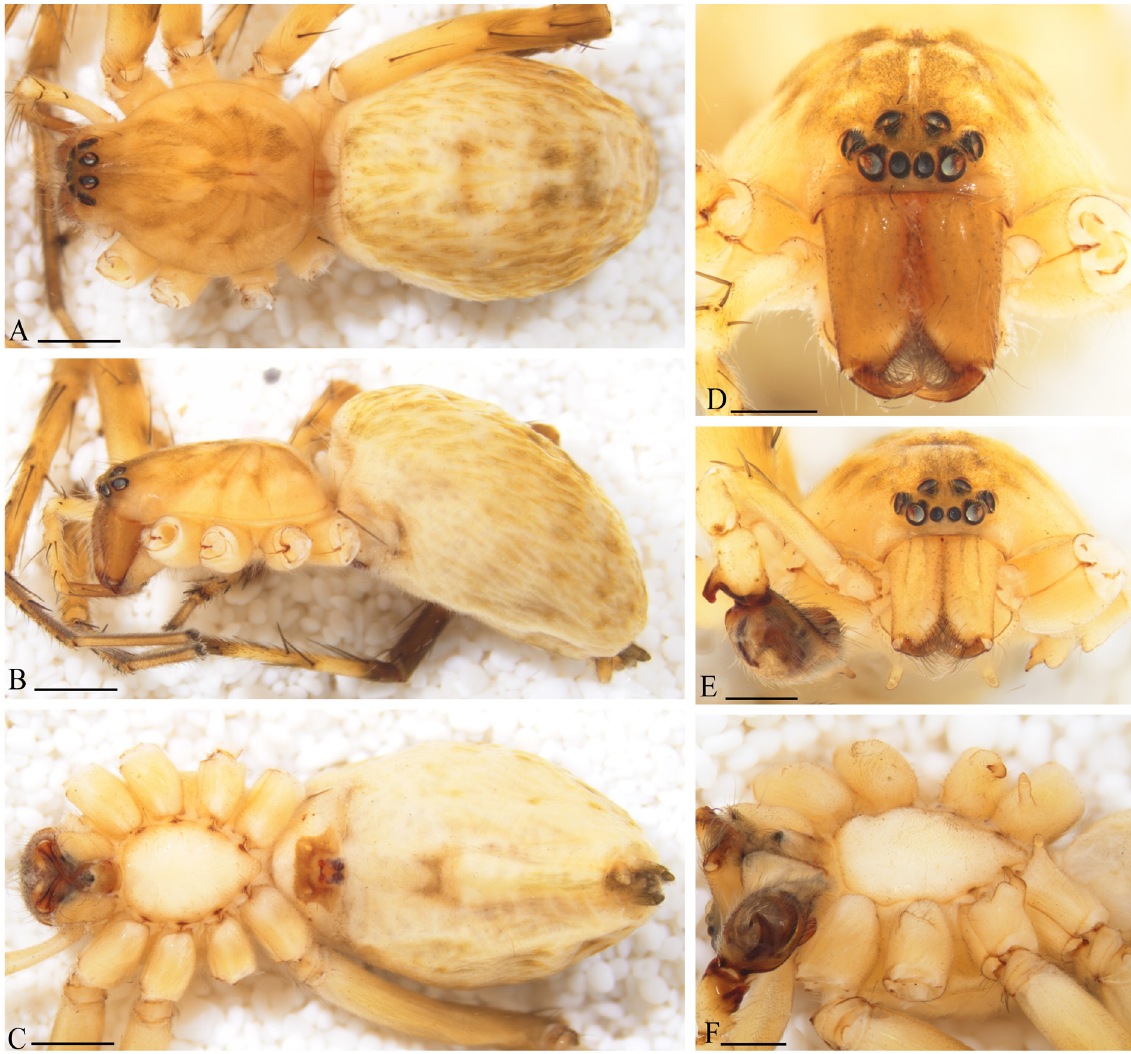
Fig. 28. Anyphaena rebecae sp. nov. A–D . Holotype, ♀ (CNAN-T01536). E–F . Paratype, ♂ (CNAN-T01568). A . Dorsal habitus. B . Lateral habitus. C . Ventral habitus. D . Prosoma, anterior view. E . Prosoma, anterior view. F . Prosoma, oblique view. Scale bars: A–C = 1.0 mm; D–F = 0.5